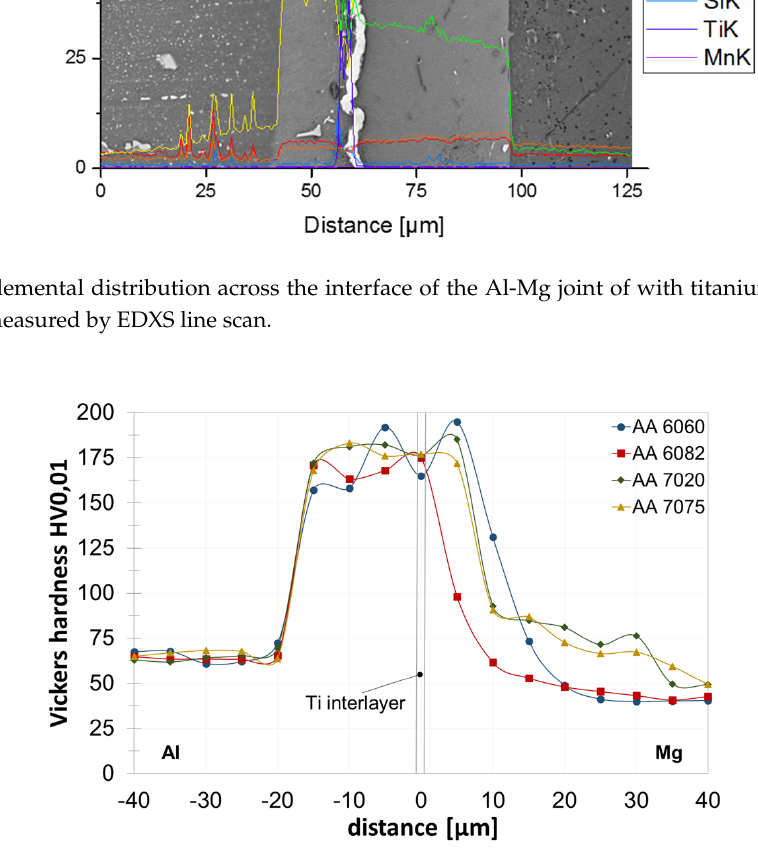
Figure 6. Hardness profiles across the interface of the diffusion-bonded Al-Mg joints with titanium interlayer.